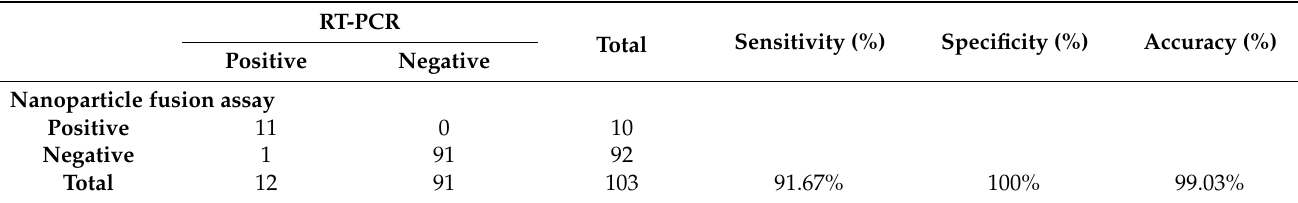
Table 1. Detection of AIV in avian fecal